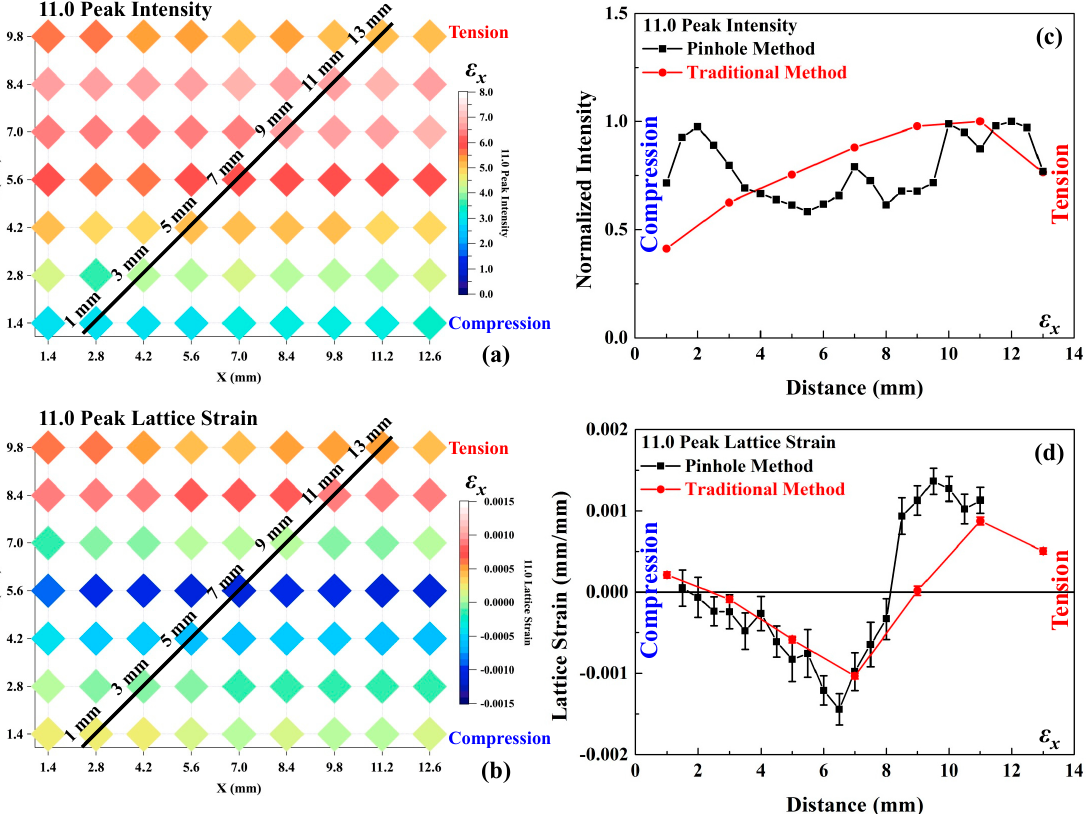
Figure 4. ( a , b ) The (11.0) peak intensity and lattice strain distributions in the ε x direction using the traditional neutron diffraction mapping method, respectively; ( c , d ) Comparison of the traditional neutron diffraction mapping and the PIND method for the (11.0) peak intensity and residual lattice strain, respectively.